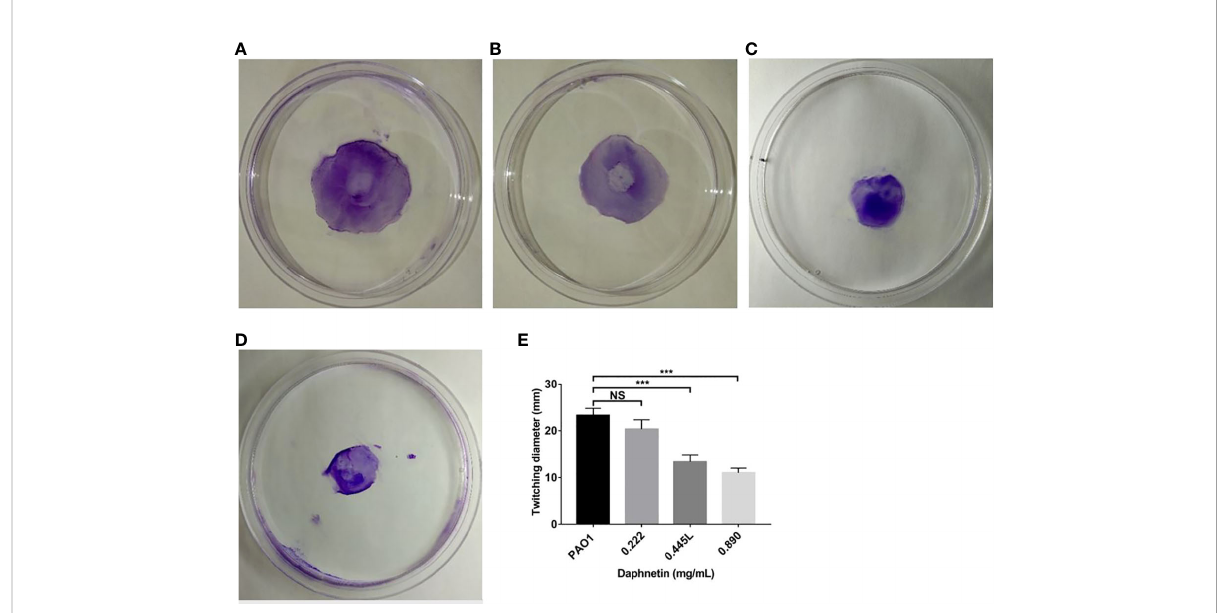
FIGURE 8 Effect of daphnetin (DAP) on twitching motility of P. aeruginosa . Twitching motility assay was conducted on plates containing different concentrations of DAP and in the absence of DAP (Untreated Control). (A) PAO1 group. (B) DAP group with fi nal concentration of 0.222 (mg/mL). (C) DAP group with fi nal concentration of 0.445 (mg/mL). (D) DAP group with fi nal concentration of 0.890 (mg/mL). (E) Twitching diameter of each group. Results are represented as the mean ± SD; NS indicates P-values >0.05 and *** indicate P-values <0.001. ANOVA test was used to compare the groups (600×600 DPI).